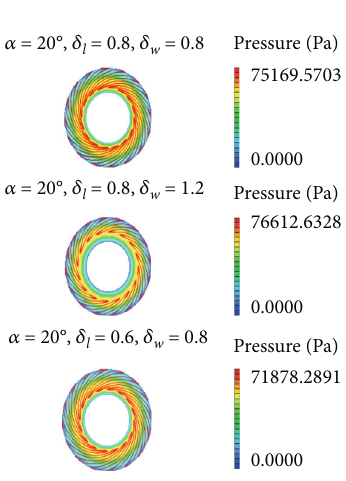
Figure 4: The pressure distribution of spiral-grooved thrust bearing with di ff erent groove